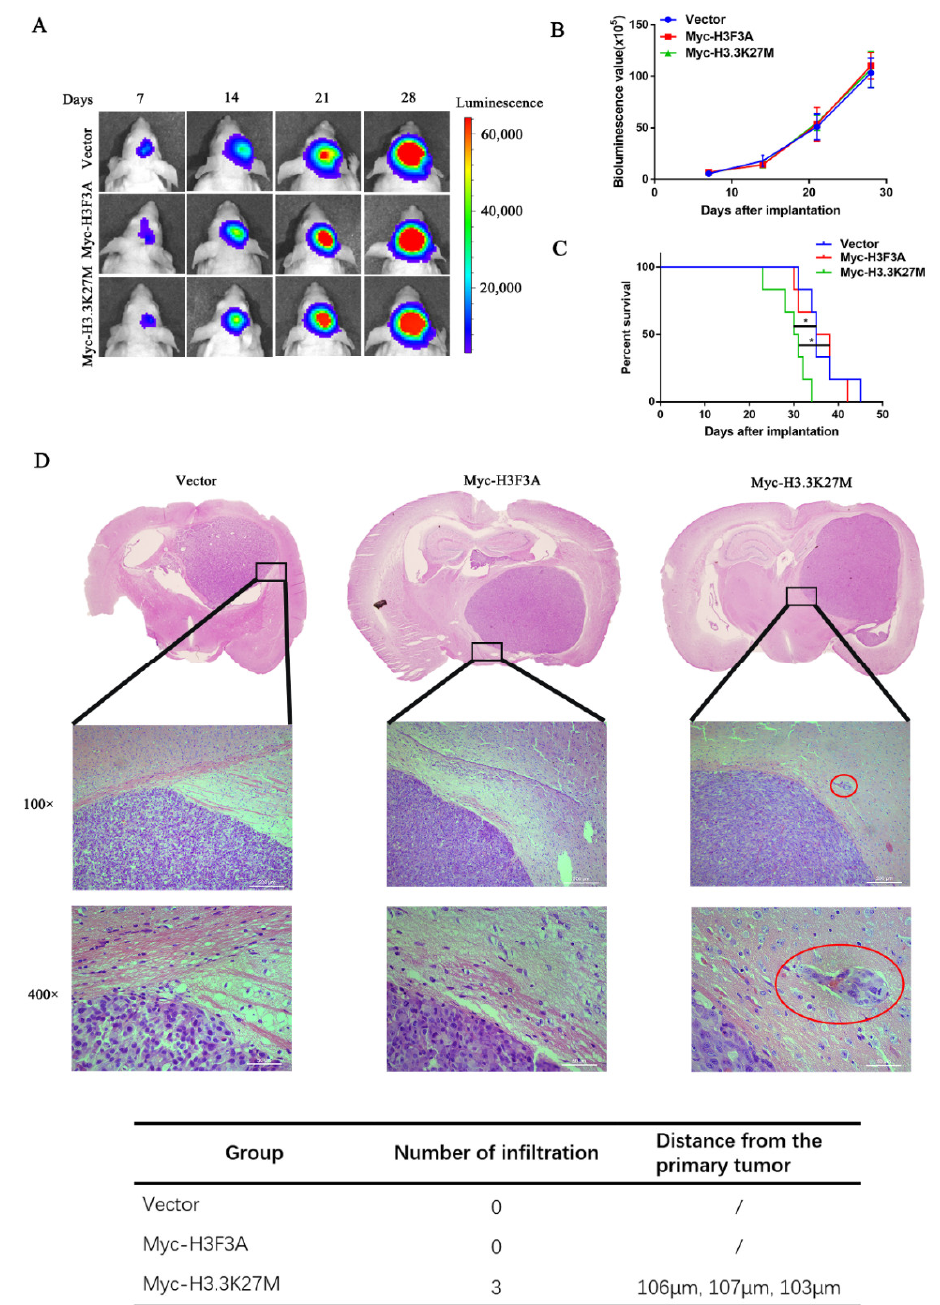
Figure 3. H3.3K27M overexpression had no effect on the proliferation of glioma cells but enhanced their invasion and migration in vivo. Bioluminescent imaging ( A ) and quantification analysis ( B ) of nude mice showed that H3.3K27M had no distinct effect on the growth rate of tumors compared with the vector group and Myc-H3F3A group. ( C ) Kaplan–Meier survival curve of nude mice injected orthotopically. H3.3K27M reduced the survival ability of nude mice. ( D ) Representative images of H&E staining in brain tissue. The Myc-H3.3K27M group showed greater infiltration than the other two groups. The red circle indicates the infiltration site. The table shows the number of infiltrating cells and their distance from the primary tumor. In this experiment, one mouse was randomly selected from each group on the 18th, 21st and 24th days after glioma cell inoculation for sectioning and H&E staining. In the vector and wild-type H3 groups, we did not observe tumor cell infiltration, but the infiltration of tumor cells were identified in the sections from three mice in the H3.3K27M mutant group. * p < 0.05; ns indicates no statistical